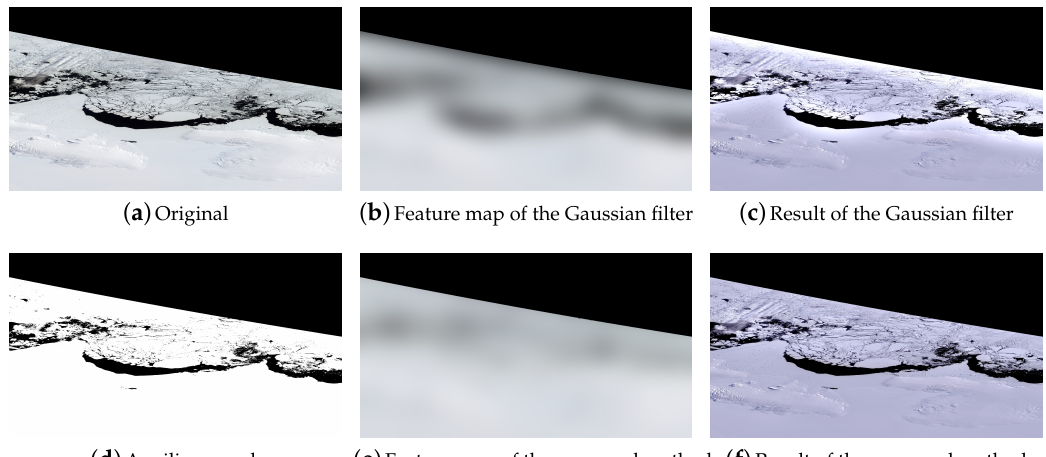
Figure 6. A comparison between the proposed method and the standard Gaussian filtering method. ( a ) Original image. ( b ) The feature map extracted by the standard Gaussian filter. ( c ) Single-view color consistency processing results using the standard Gaussian filter. ( d ) The auxiliary mask of the sample image. ( e ) The feature map extracted by the proposed filter. ( f ) Single-view color consistency processing results using the proposed filter.